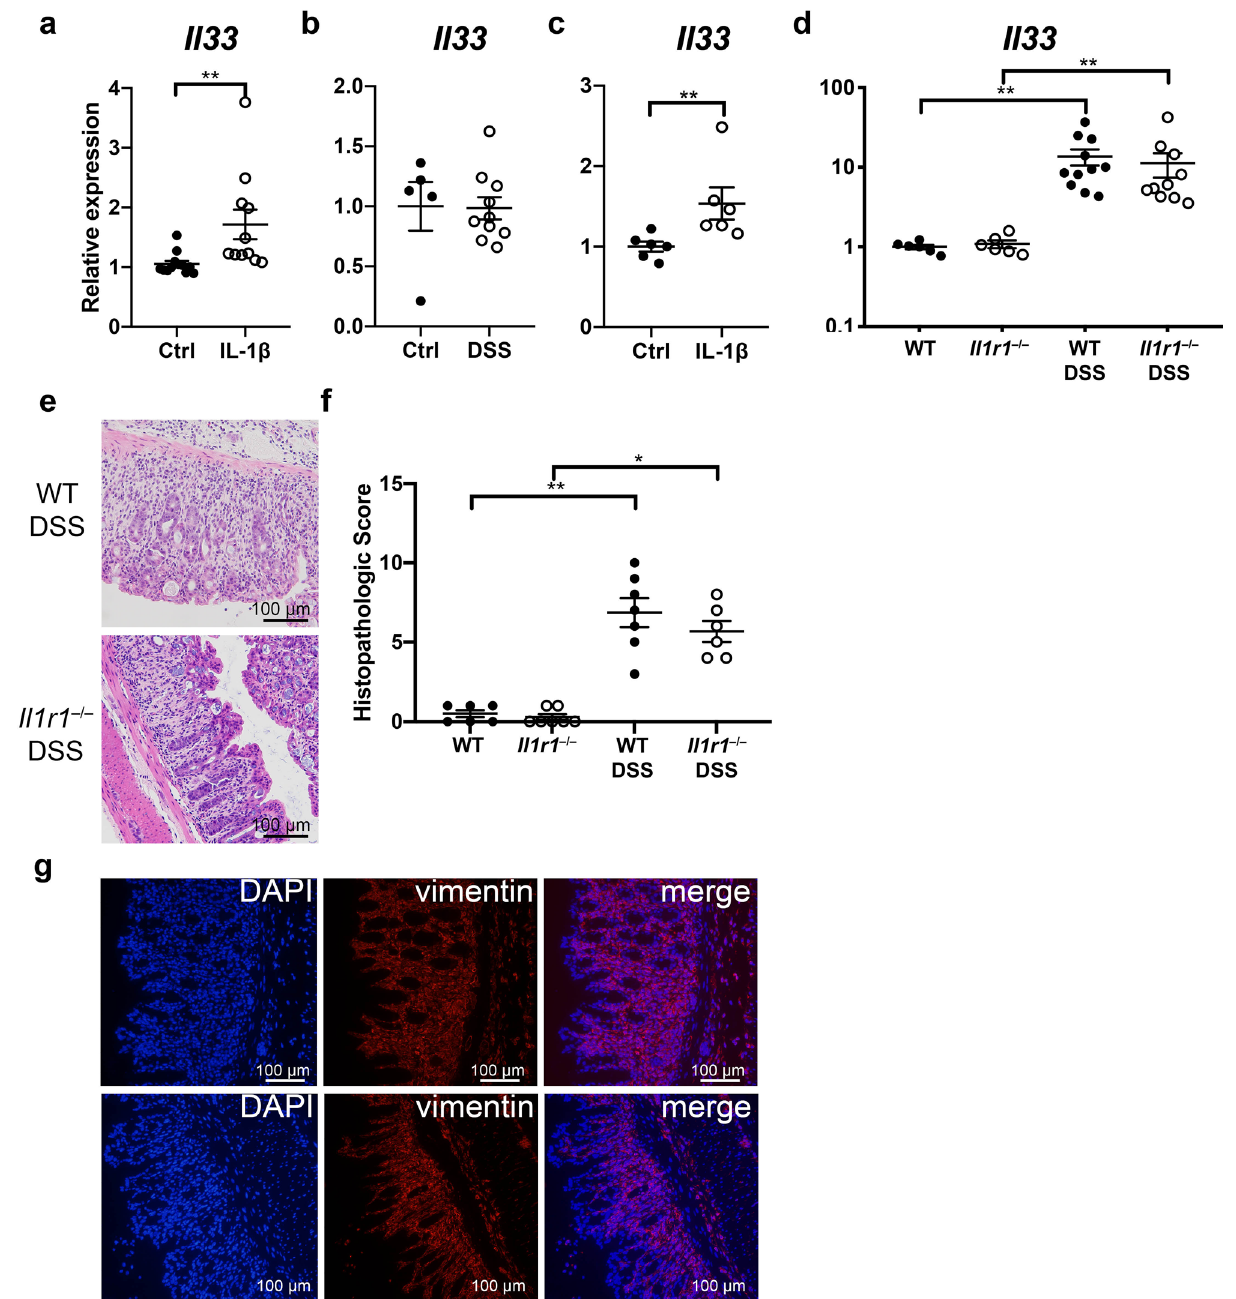
Figure 4. IL-1β induced Il33 expression in colon fibroblasts in vitro. Il33 expression assessed by real-time RT-PCR in ( A ) IL-1β treated and untreated colon myofibroblast WEHI-YH2 cells from 3 independent experiments and ( B ) Citrine + cells sorted from Control and DSS-treated Il33 Cit /+ mice. ( C ) Citrine + cells sorted from DSS-treated Il33 Cit /+ mice stimulated with IL-1β, and ( D ) colon tissue from WT and Il1r1 −/− mice given DSS. ( E ) Representative H&E staining and ( F ) histopathologic scores of WT and Il1r1 −/− mice treated with DSS. ( G ) Representative images of vimentin immunofluorescent staining. N = 5–10 mice/group, *p < 0.05, **p < regulates Il33 expression in colon myofibroblasts, as has been reported by others 15 . The WEHI-YH2 colon myofi- broblast cell line 30 was stimulated with IL-1β for 18 h and Il33 expression was analyzed. IL-1β increased Il33 in WEHI cells compared to control (Fig. 4A). To examine primary cells, citrine + cells were sorted from control and DSS-treated mice. Although Il33 was not increased in unstimulated citrine + cells from DSS-treated mice com- pared to those from control mice (Fig. 4B), ex vivo stimulation with IL-1β increased Il33 expression in citrine + cells from DSS-treated mice (Fig. 4C), indicating that IL-1β could play a role in the regulation of IL-33 in the colon during colitis.